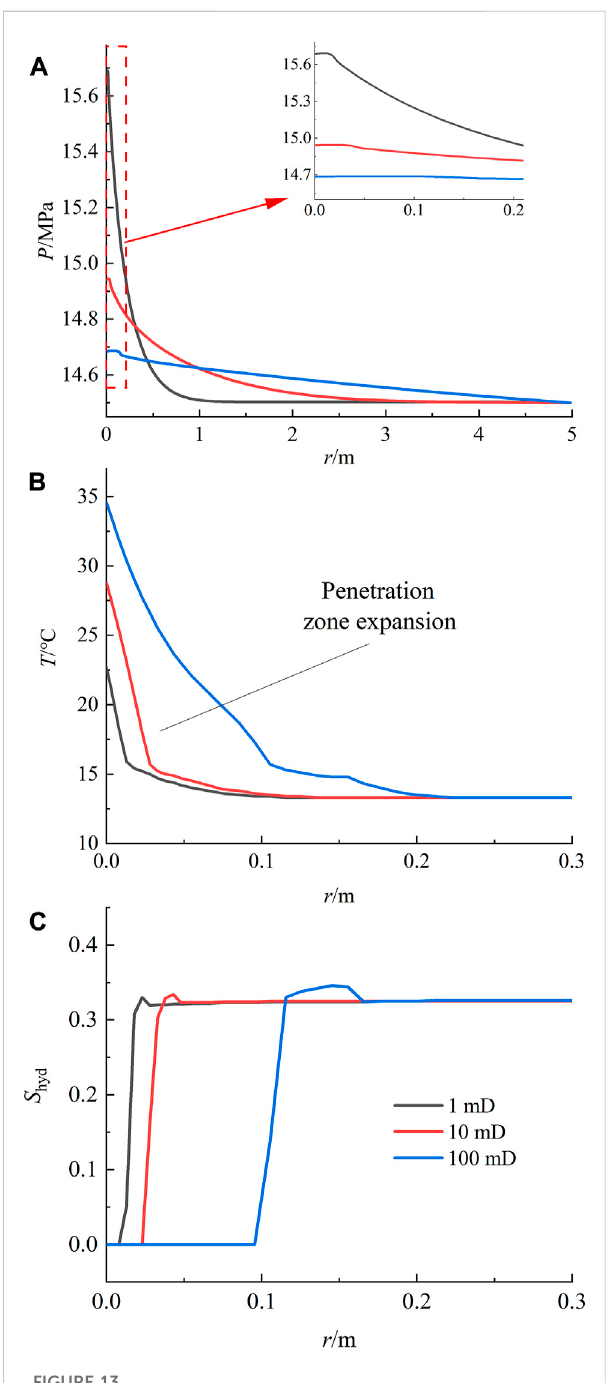
FIGURE 13 Changes in the main physical properties of the sediment around the wellbore at 25 min at different absolute permeabilities. (A) Pressure. (B) Temperature. (C) Hydrate